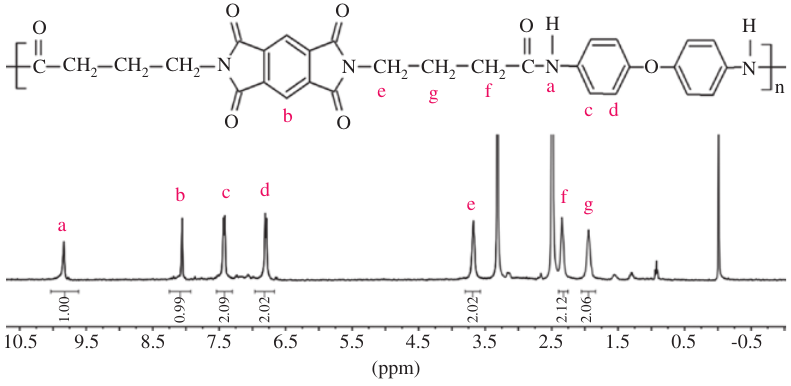
Figure 5: 1 HNMR spectra of PAIc.